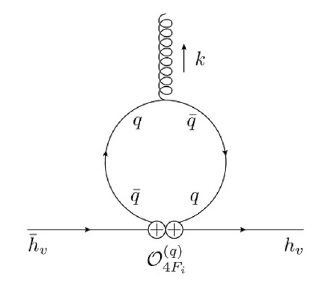
Figure 3 . One-loop diagrams contributing the renormalization of C D